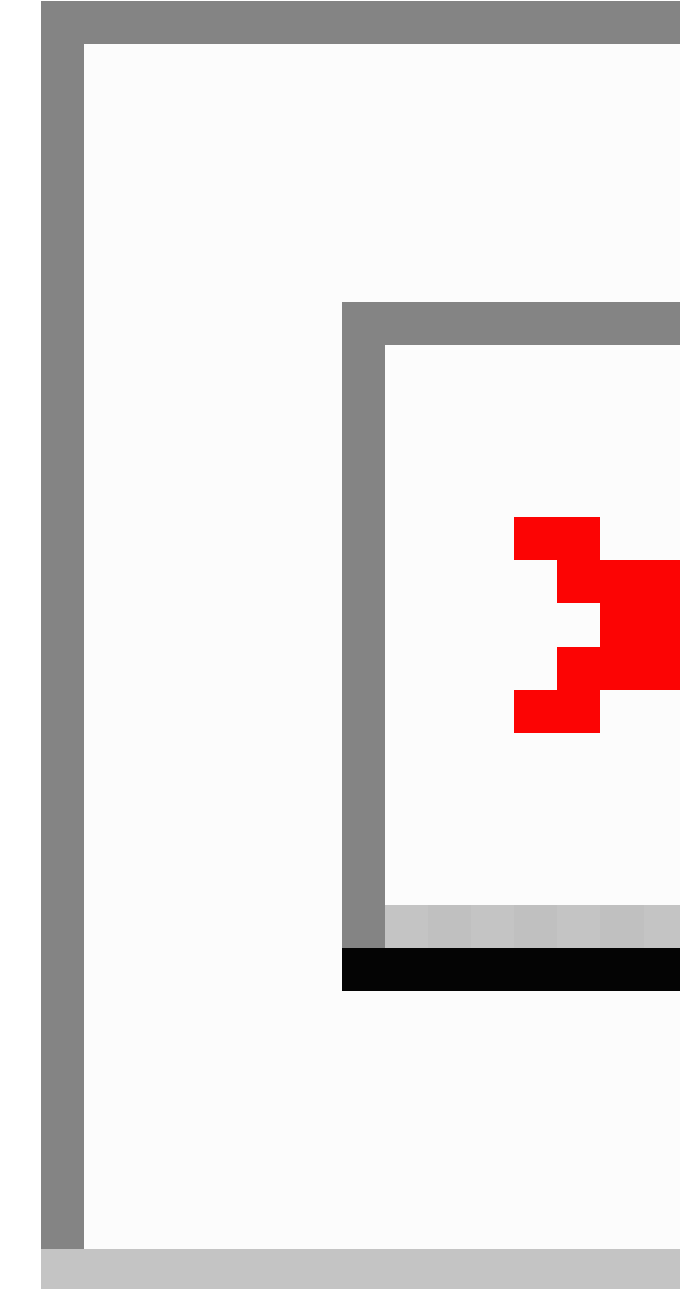
Figure 7. Distribution of the search queries based on type of yes/no